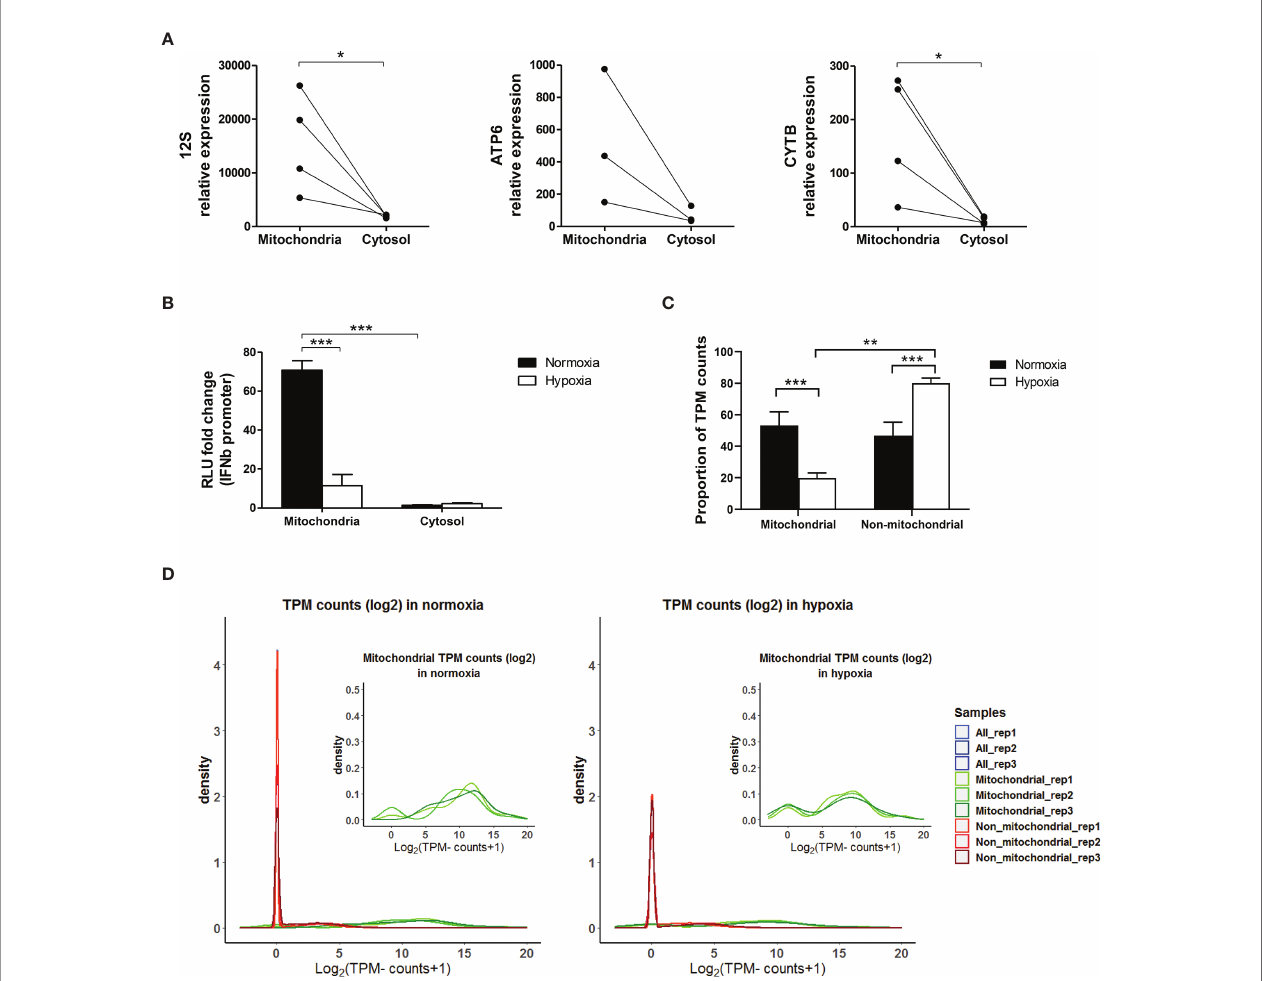
FIGURE 8 | Mitochondrial RNA is responsible for IFN b promoter activation. (A) MCF7 cells cultured in normoxia for 48h were fractionated. RNA expression of mitochondrial encoded genes ( 12S, ATP6, CYTB ) in mitochondrial and cytosolic fractions is shown by qPCR (n=3 or 4). (B) MCF7 cells cultured in normoxia or 0.1% hypoxia for 48h were fractionated and RNA from the mitochondria and cytosolic fractions was used to activate the IFN b promoter (n=3; RLU, relative light units). (C) dsRNA pull down experiment using J2 antibody in MCF7 cells exposed to normoxia or 0.1% hypoxia for 48h was performed. Bar graph shows proportion of transcripts per million (TPM) mitochondrial and non-mitochondrial reads (n=3). (D) Density plots show mitochondrial (green), non-mitochondrial (red) and all reads (blue) in each replicate (rep) obtained from the dsRNA pull-down experiment in (C) (n=3). Number of replicates indicate biological replicates and data is shown as mean ± SEM. *p < 0.05, **p < 0.01, ***p <